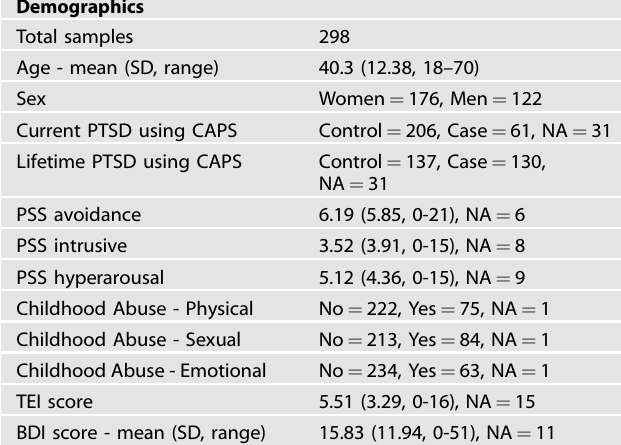
Demographic characteristics are described as counts for categorical variables and mean (SD, range) for continuous variables. CAPS